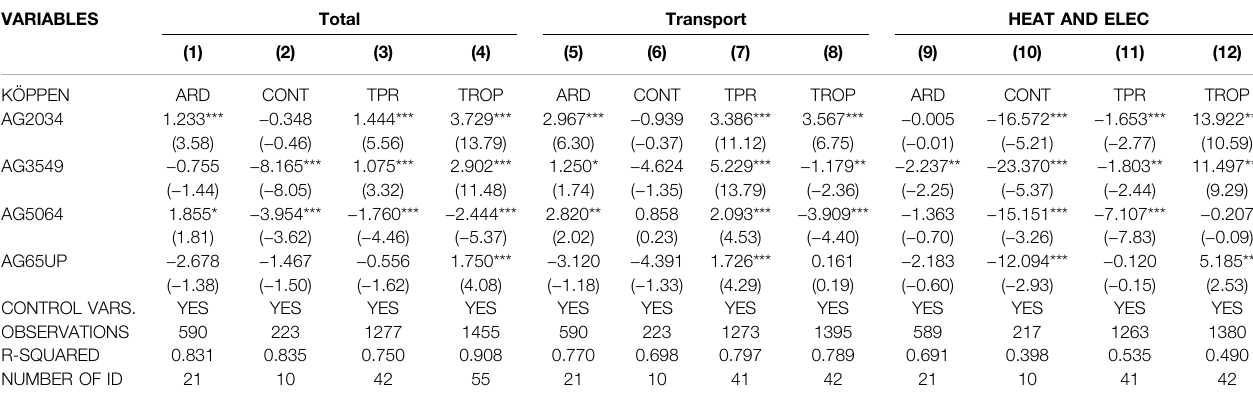
TABLE 8 | Sample group divided by climate types with carbon emission